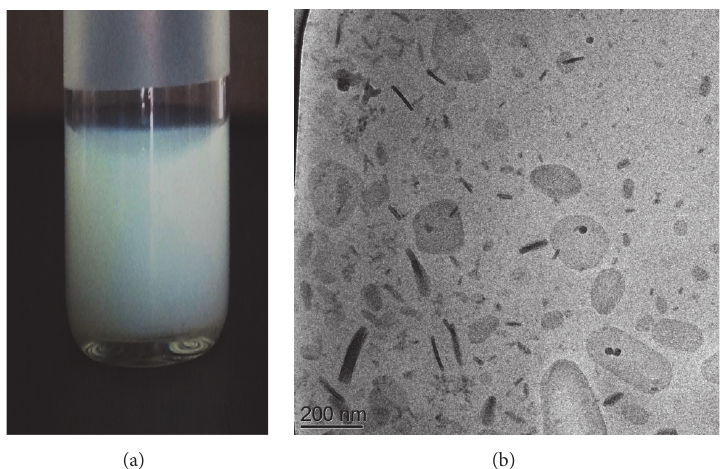
Figure 1: Macroscopic aspect (a) and cryotransmission electron microscopy (cryo-TEM) image (b) of the produced NAF.